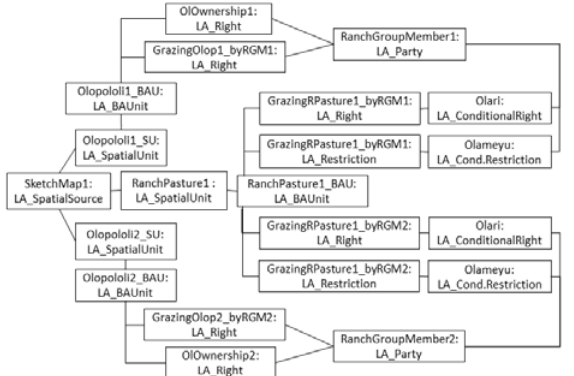
Figure 4. Human-land relation LADM diagram with conditional RRR based on climate (Scenario